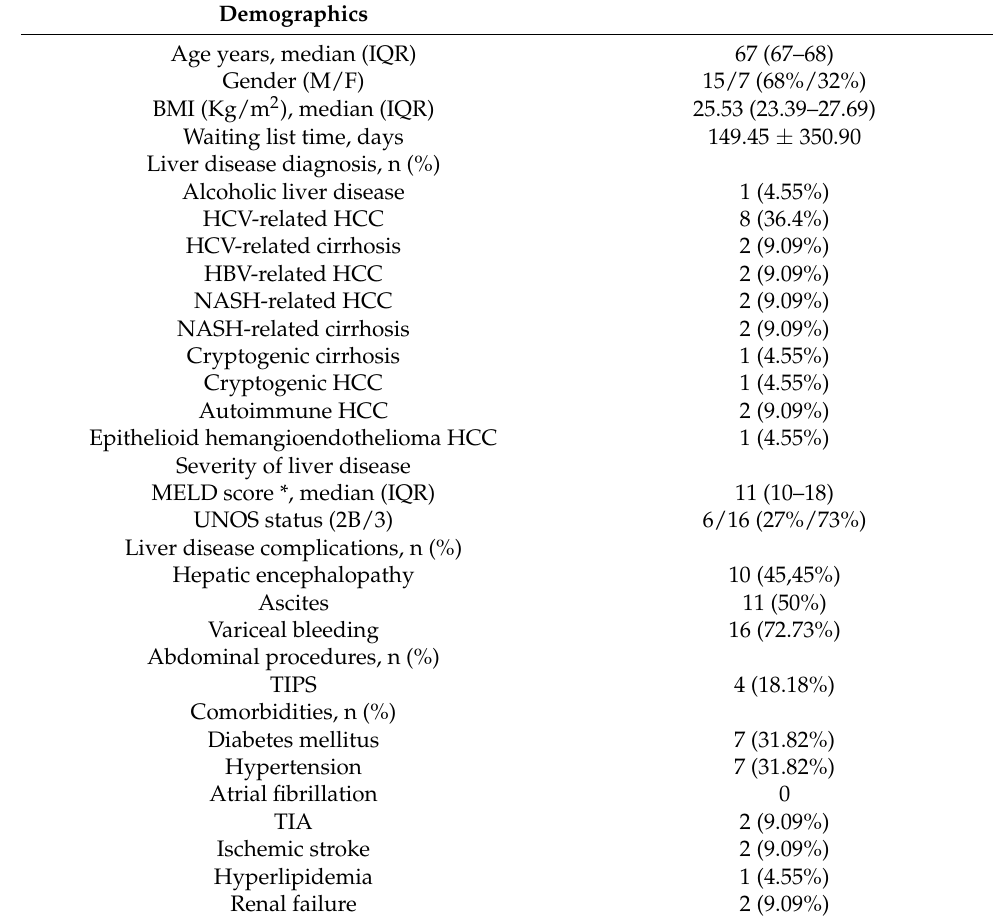
Table 1. Patients’ baseline demographic and clinical